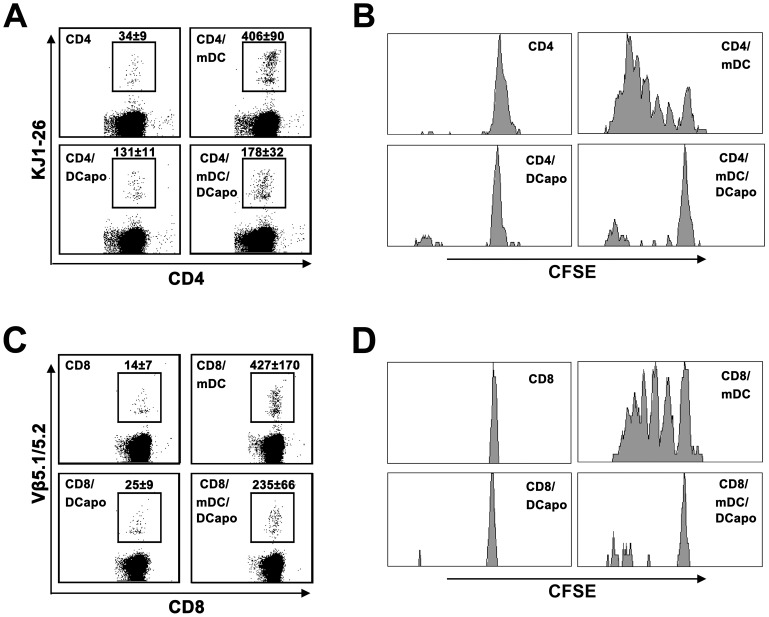
Inhibition of T cells proliferation by DCapos in vivo. (A) CD4+ T cells (5×106 cells) from DO11.10×C57BL/6 F1 hybrid mice stained with CFSE, OVA323–339-loaded mDCs (1×106 cells) with or without DCapos (1×106 cells) were transferred together into the peritoneal cavity of normal mice for 4 days. Mononuclear cells from the blood were separated and stained for flow cytometric analysis of the frequency of both CD4- and KJ1-26-positive T cells. (B) The CFSE dilutions of CD4+KJ1-26+ T cells were analyzed using flow cytometry. (C) OT1 CD8+ T cells (1×106 cells), OVA257–264-loaded mDCs (3×105 cells) with or without DCapos (3×105 cells) were transferred together into the peritoneal cavity of normal mice for 3 days. Then, the mononuclear cells were separated from the blood and stained for flow cytometric analysis of the frequency of both CD8- and Vβ5.1/5.2-positive T cells. (D) The CFSE dilutions of CD8+ Vβ5.1/5.2+ T cells were analyzed by flow cytometry. Data are presented as mean ± SD of 5 mice, and results represent 1 of the 2 experiments with similar results.